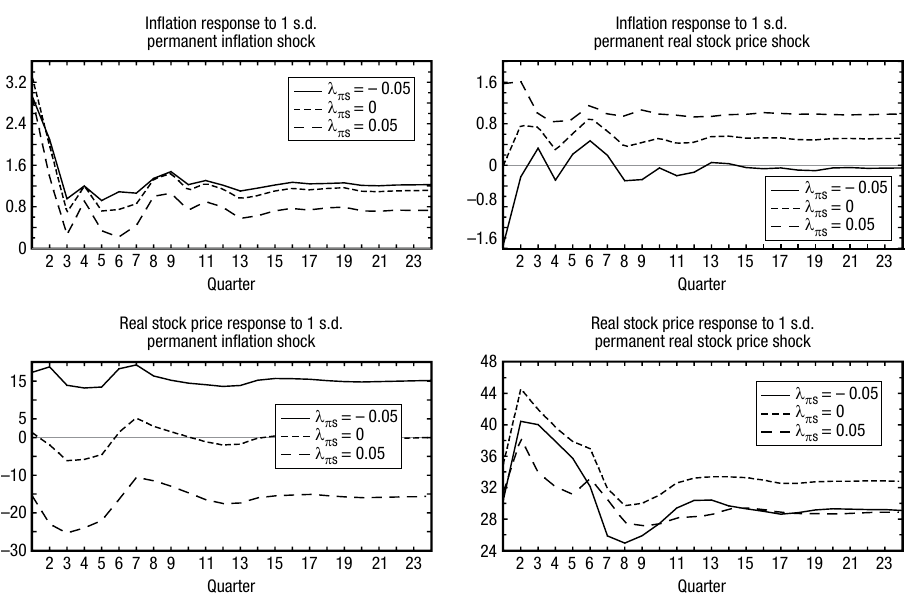
Fig. 2. Inflation and real stock price impulse responses for different assumed l p